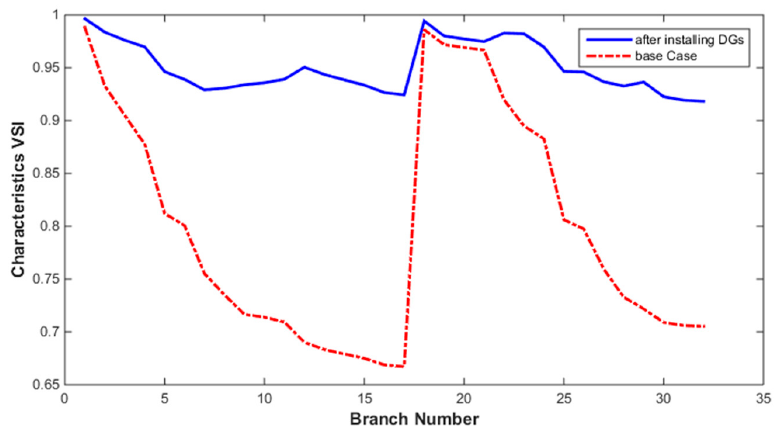
Figure 10. Characteristics of VSI at unity pf.